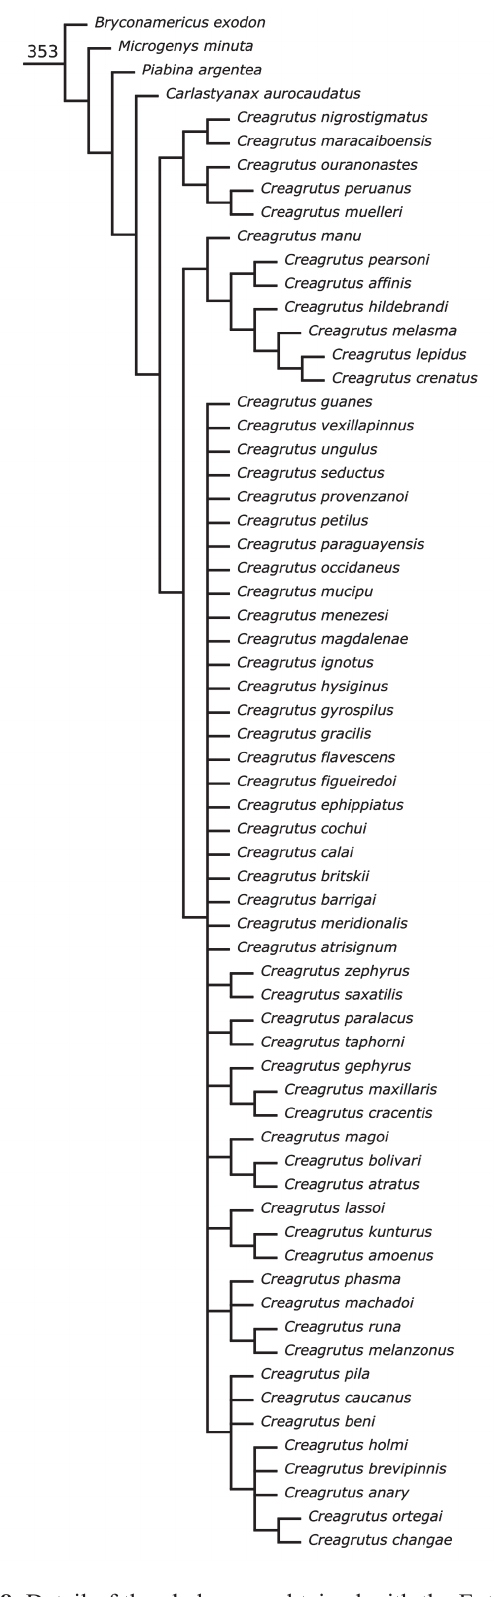
Fig. 8. Detail of the cladogram obtained with the Extended Matrix. Clade 353 corresponds to the clade with the same number in Fig.